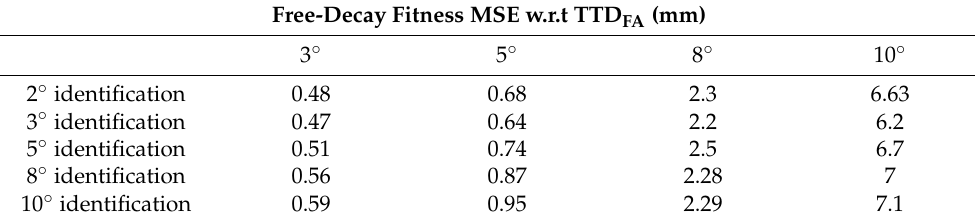
Table 5. Initial platform pitch selection results.